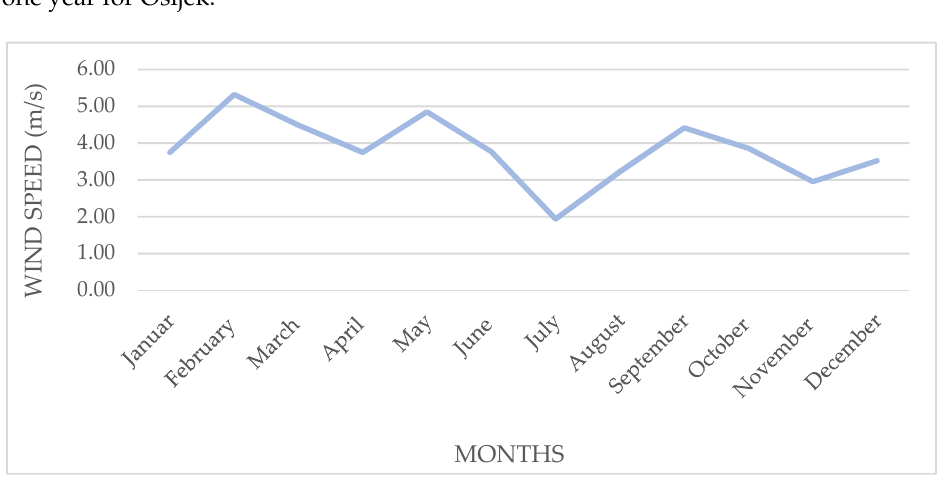
Figure 4. Average wind speed for Osijek. In Table 2. all the characteristics of hybrid off ‐ grid system components: PV module, battery and wind turbine are shown. Table 2. Characteristics of hybrid off ‐ grid system components.